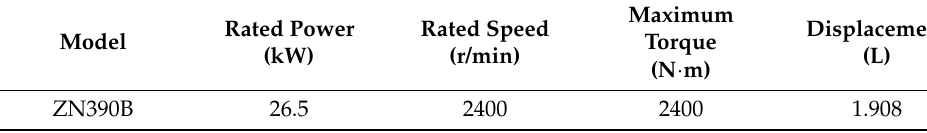
Table 4. Main performance parameters of the ZN390B diesel engine.